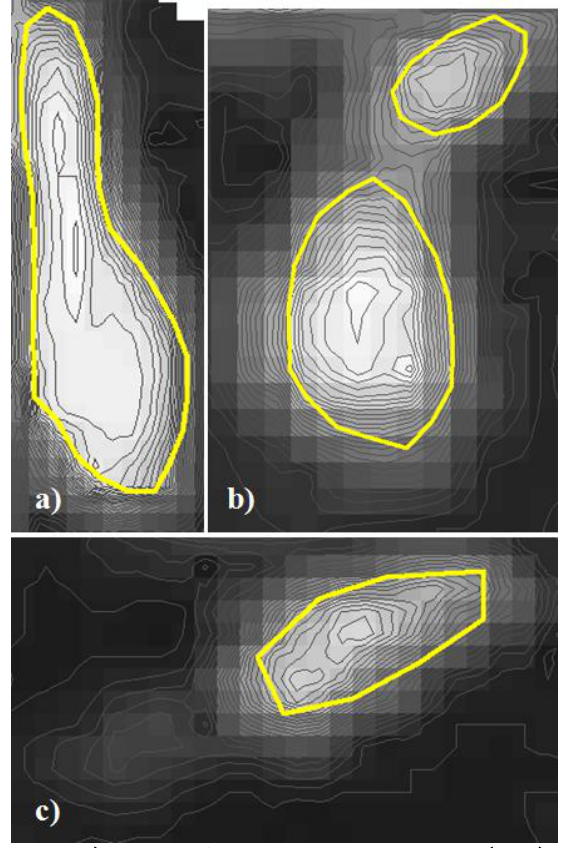
Figure 3: a) Example of a completely emerged animal (CEA); b) Example of a pair of polygons corresponding to a single animal (PPSA); Example of a nearly immerged animal (NIA).